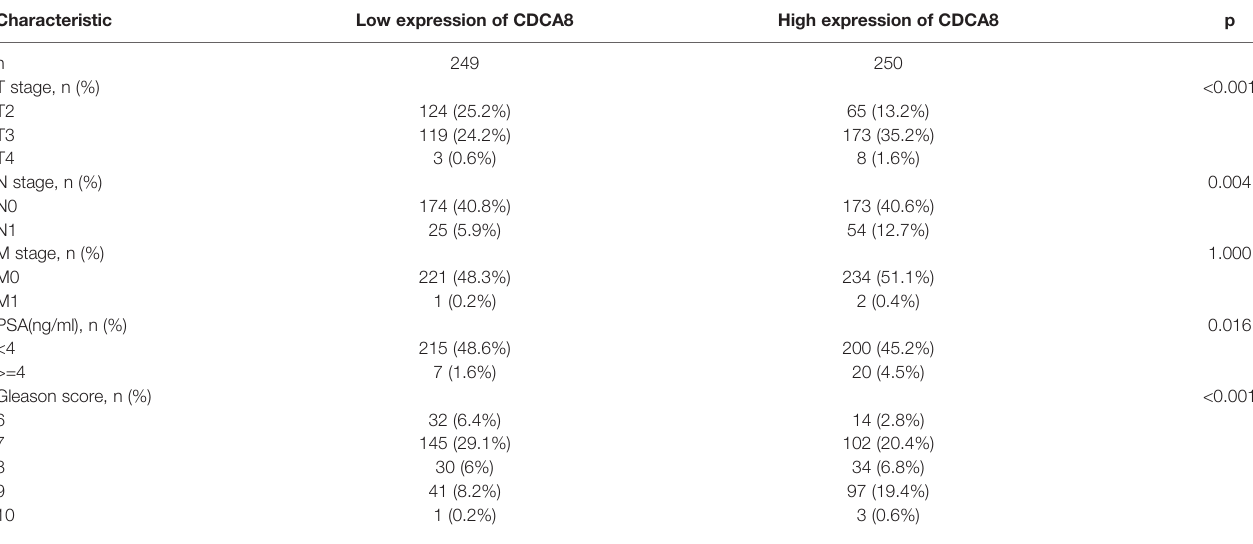
TABLE 1 | Clinical features of PCa associated with CDCA8. Characteristic